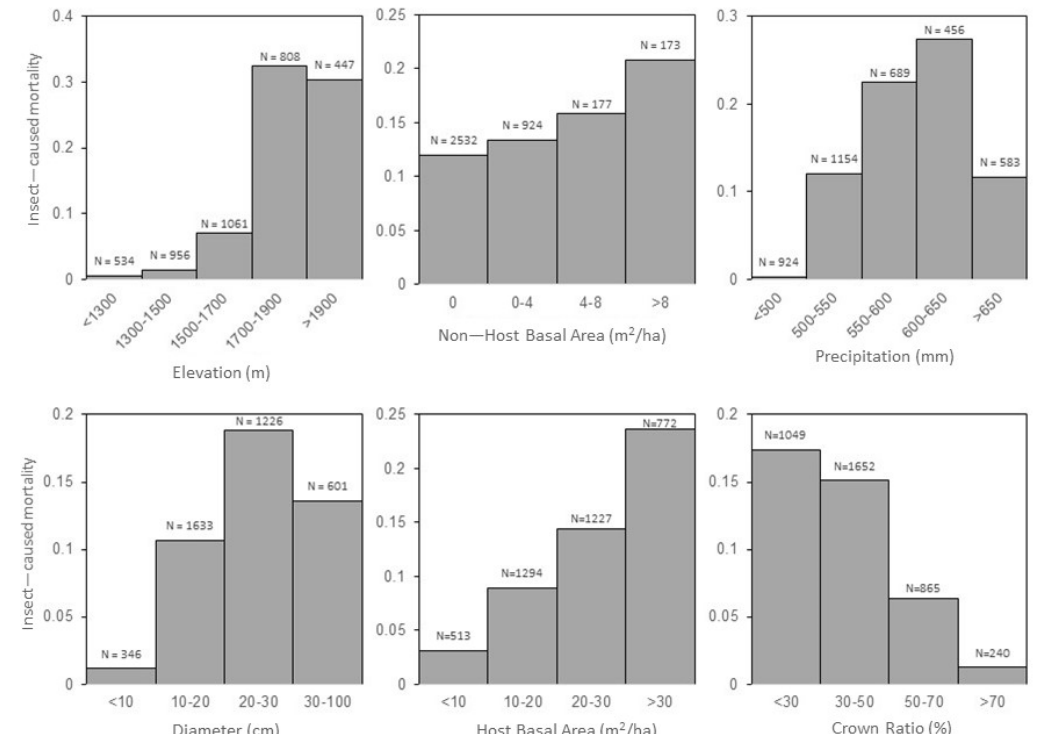
Forests 2021 , 12 , x FOR PEER REVIEW